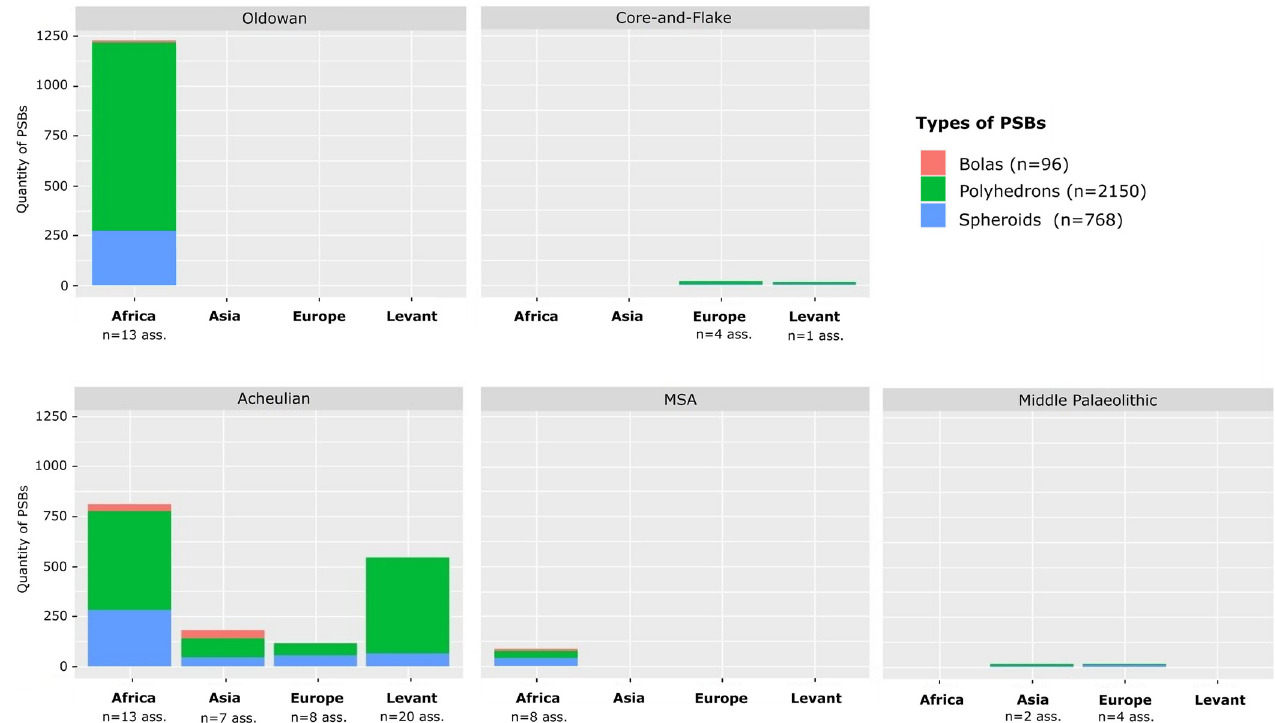
Fig 4. Quantities of polyhedrons, spheroids and bolas in assemblages according to chrono-cultural attributions and regions. Ass.: Assemblages.